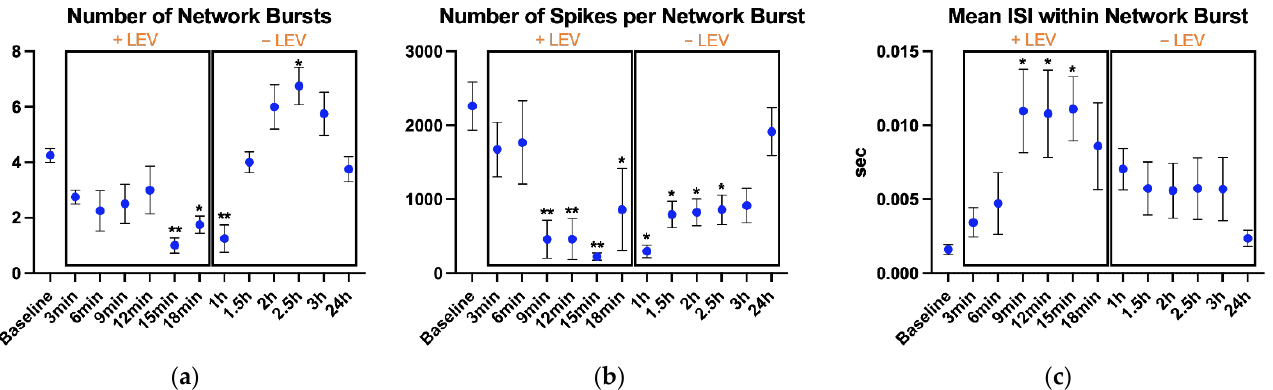
Figure 4. Network bursting parameters: ( a ) number of network bursts, ( b ) number of spikes per network burst, and ( c ) mean ISI within network burst. After the baseline recording, LEV was added to the cell culture and its effects were monitored every 3 min up to 18 min; then, the cell medium was replaced to remove LEV and cell activity was monitored every 30 min up to 3 h and finally, one recording was performed at 24 h. The cultures were kept at 37 °C under a 5% CO 2 atmosphere during the recordings. Data are expressed as mean ± SEM of four independent experiments. All comparisons are performed vs. the baseline. * p < 0.05; ** p < 0.01.